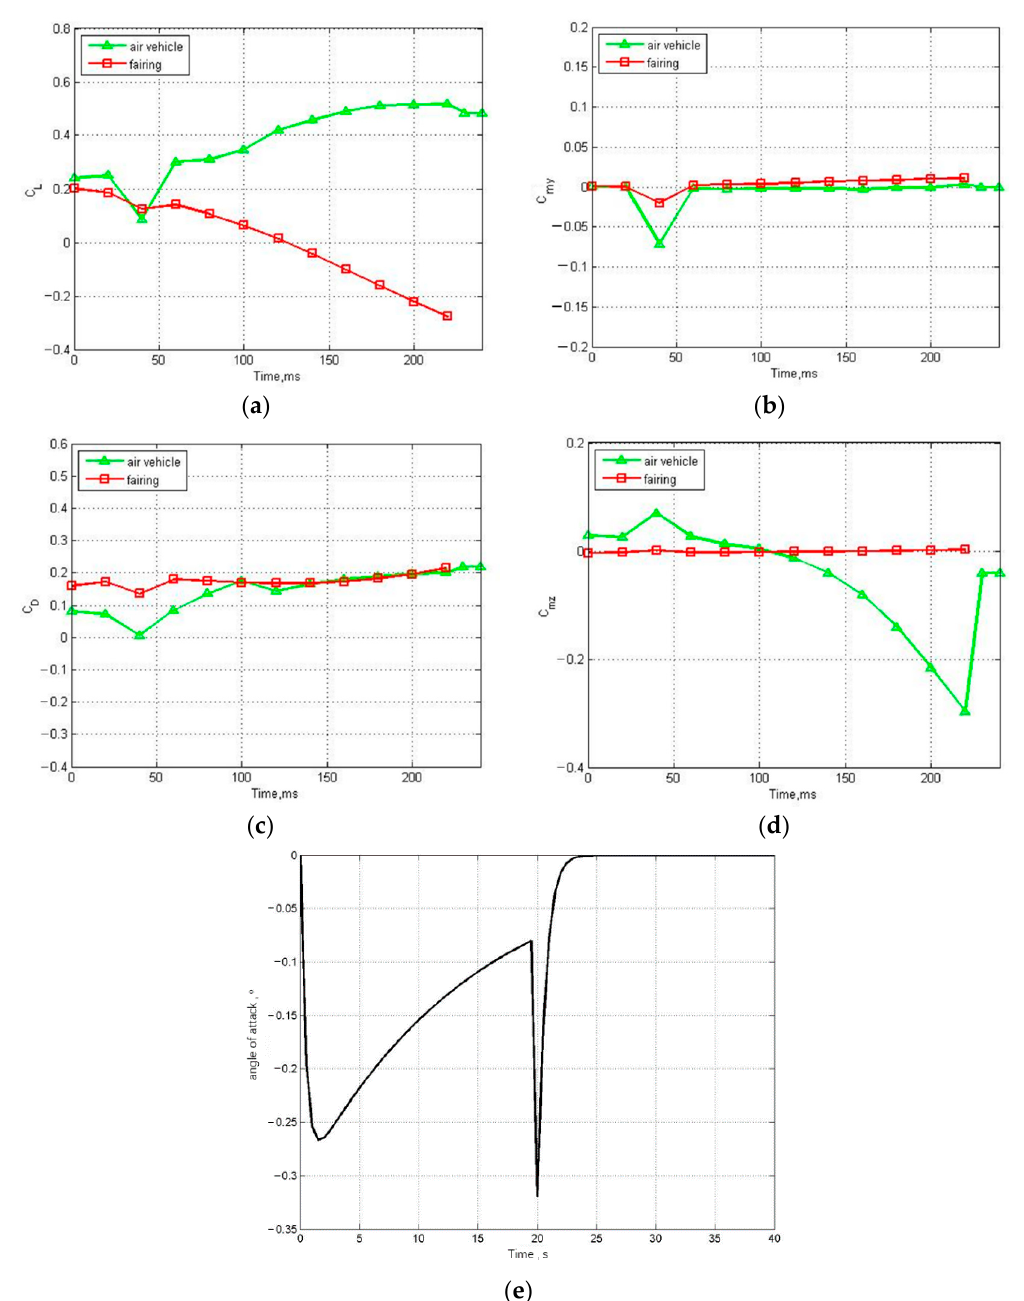
Figure 5. ( a )Variation in the lift coefficient with time; ( b ) variation in the lateral force coefficient with time; ( c ) variation in the drag coefficient with time; ( d ) variation in the pitching moment coefficient with time; ( e ) angle of attack with interference.